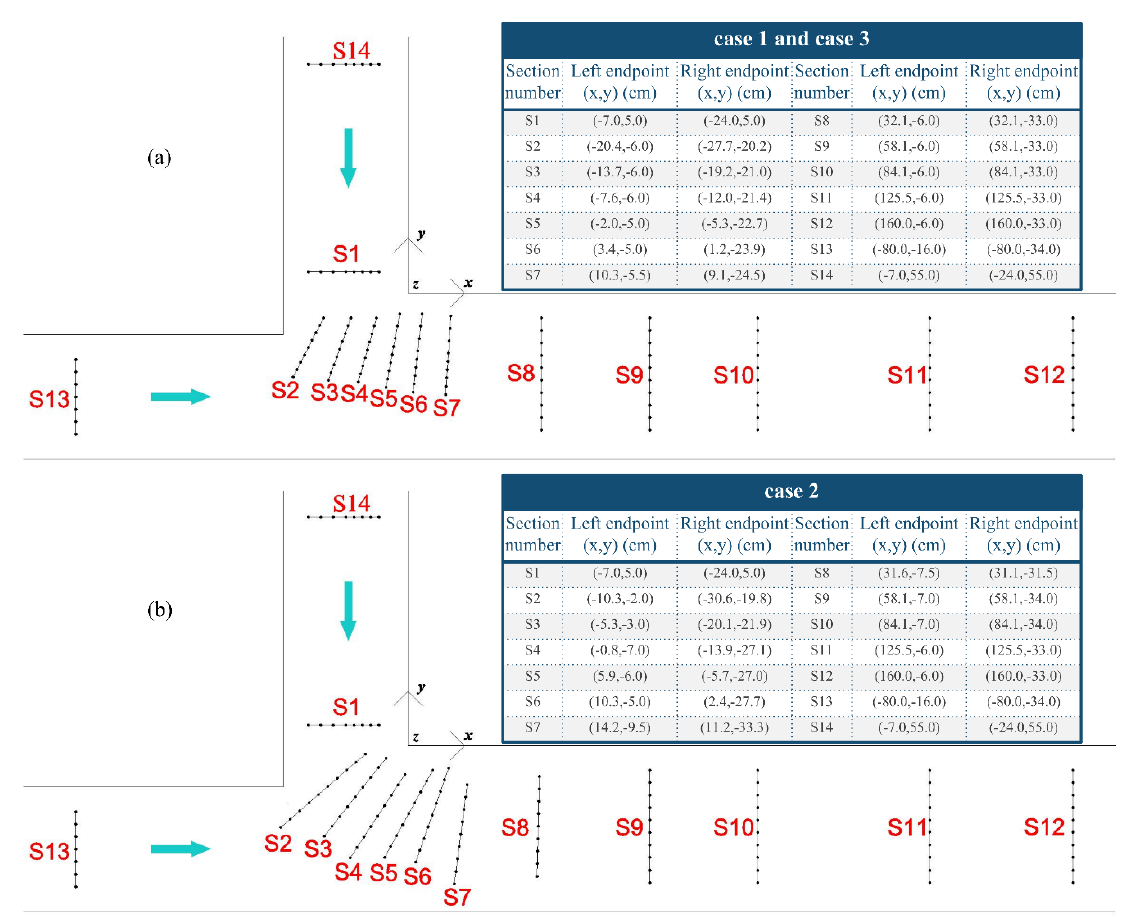
Figure 2. Schematic diagram of measurement cross sections. ( a ): case 1 and 3, R q = 0.4; ( b ): case 2, R q = 0.6.